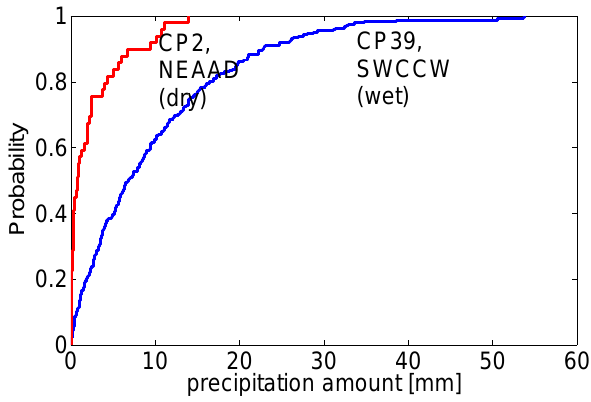
Fig. 15. Empirical CDF of observed precipitation in Garmisch-Partenkirchen, conditioned on the occurrence of the Northeast advection type WT 2 (NEAAD), and the Southwest advection type WT 39 (SWCCW).